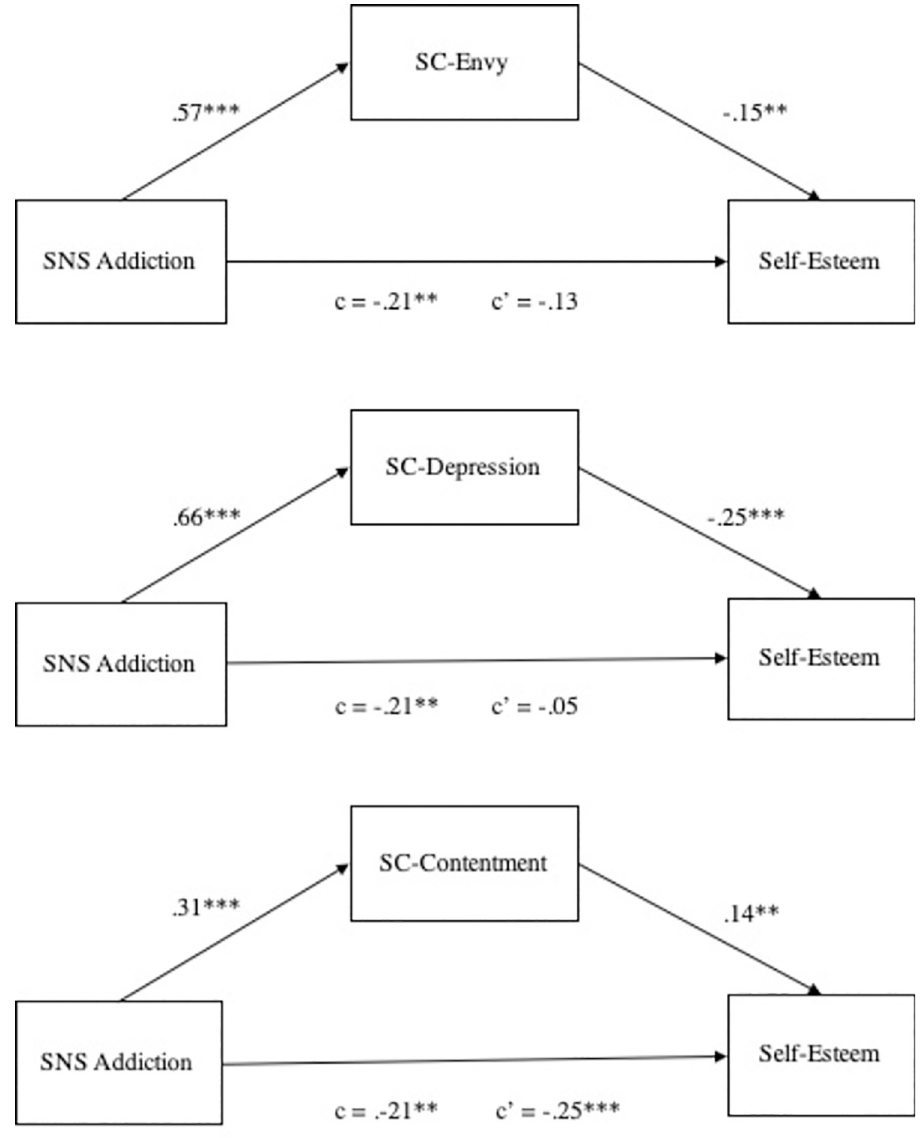
Fig 3. The mediating role of SC-envy and SC-depression on the relation between SNS addiction and self-esteem. Note. In the mediation model via SC-contentment, due to the indirect effect (.04) being positive and the direct effect being negative (-.25), the indirect and direct effects cancelled each other out (c = -.21; inconsistent mediation; [85]). In this case, an appropriate interpretation of the size of the total effect can be the combination of the absolute values of indirect and direct effects (c = .29;